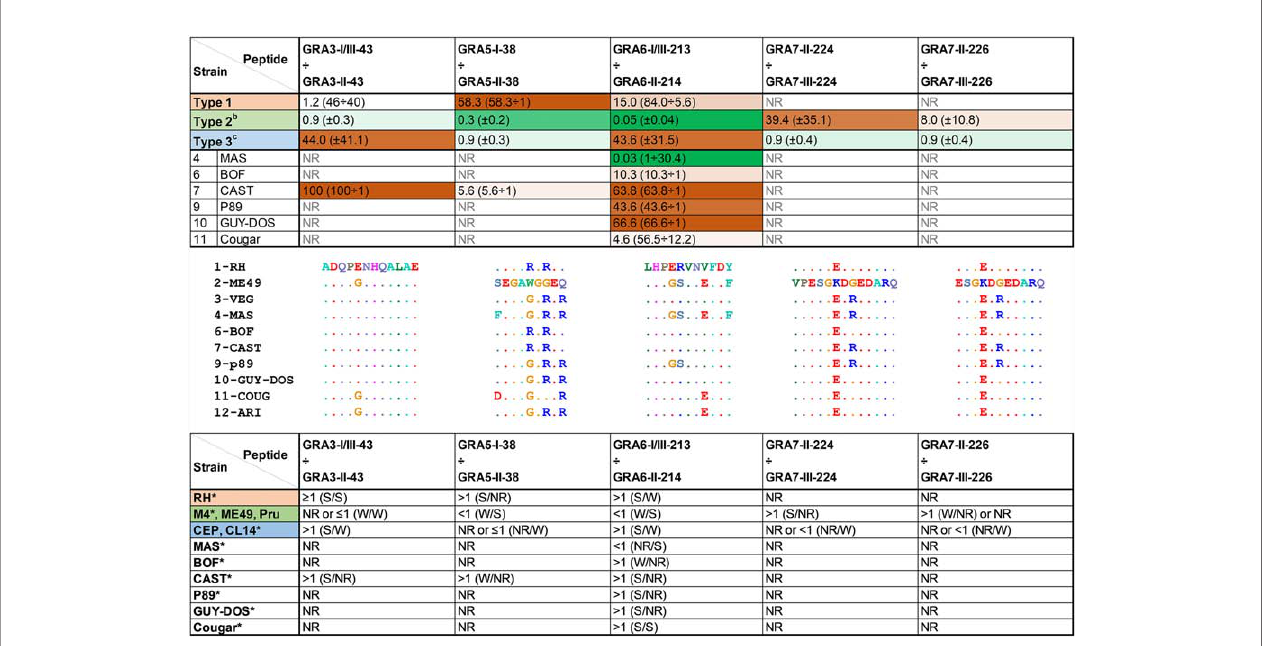
FIGURE 2 | Different Toxoplasma strains show a unique pro fi le of seroreactivity against speci fi c GRA peptides. Ratio values from strain-speci fi c peptides assayed with serum samples from mice infected with different Toxoplasma strains. Ratios were calculated by dividing the RIPC values of speci fi c peptides with the homologous version from the different strain types (in parenthesis). Ratios greater than 1 were highlighted with an increasing brown color (being 100 the most intense), whereas values between 1 and 0 were highlighted in an increasing green color (being 0 the most intense). NR, non-reactive, designates ratios of 1 derived from samples that did not react to any of the two peptides. As a reference, type 1 RH, as well as the average ratio for individual M4, ME49 and PRU type 2 ( b ) and CEP and CL14 type 3 ( c ) samples are shown. Readers are referred to Supplemental File 3 for details on individual values and standard deviation. The speci fi c peptide amino acid sequence for each of the strains is displayed in the middle of the fi gure, where dots represent identical residues. Type 12 Ari strain has been added for comparative purposes. At the bottom, predictions were made based on the ratio obtained for each infection type. Ratios were classi fi ed as non-reactive (NR, when both peptides in the division had an RIPC value of 1), lower than 1 (<1), lower but close or almost equal to 1 ( ≤ 1), higher but close or almost equal to 1 ( ≥ 1) or higher than 1 (>1). The strength (S, strong; W, weak) of each peptide is indicated in parenthesis and separated by a division mark (/). * indicates a single strain